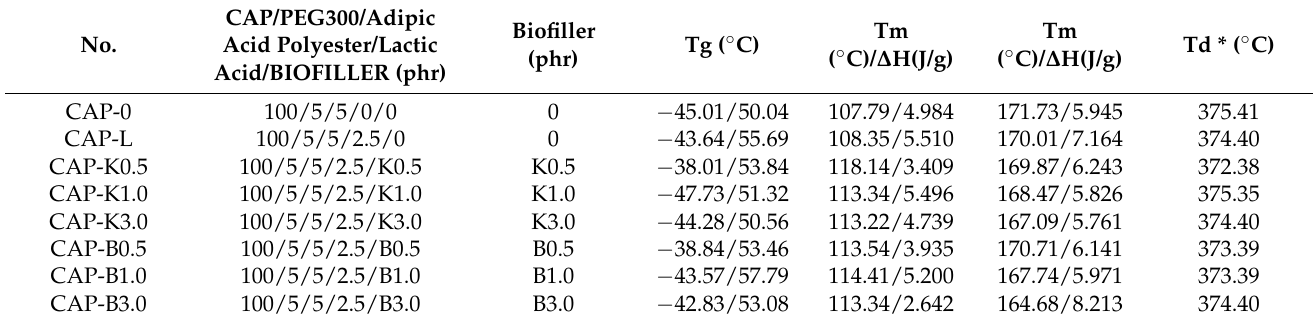
Table 4. The compositions and thermal properties of the CAP–biofiller